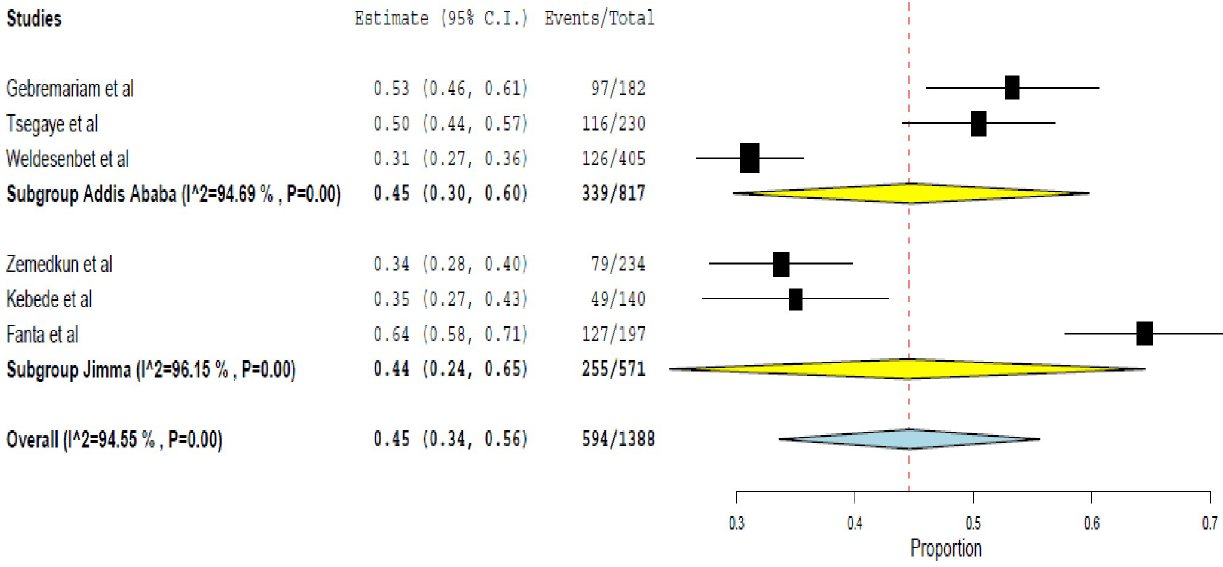
Fig 2. Rate of uncontrolled asthma assessed using the GINA symptom control.